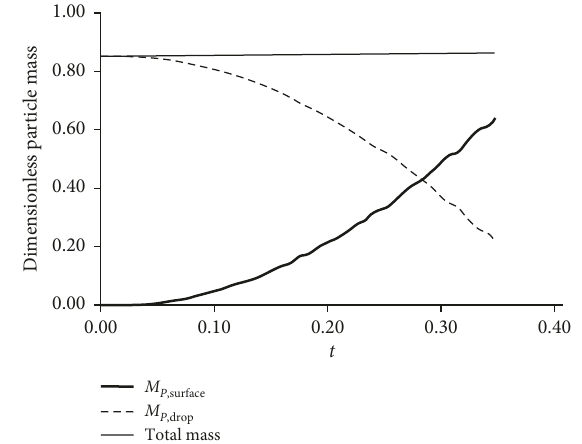
Figure 13: Particle mass change versus time for the case of water sessile drop suspended with Si particles (Pe � 138.5; Da � Da − 1 � 0; initial particle concentration � 0.65 wt.%; initial AR � 0.5, H � 0.5).